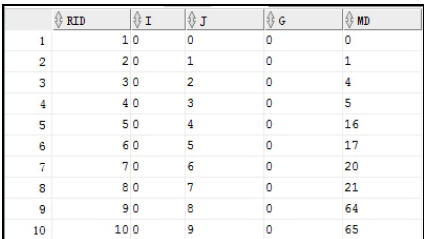
Figure 5. Raster data table in oracle